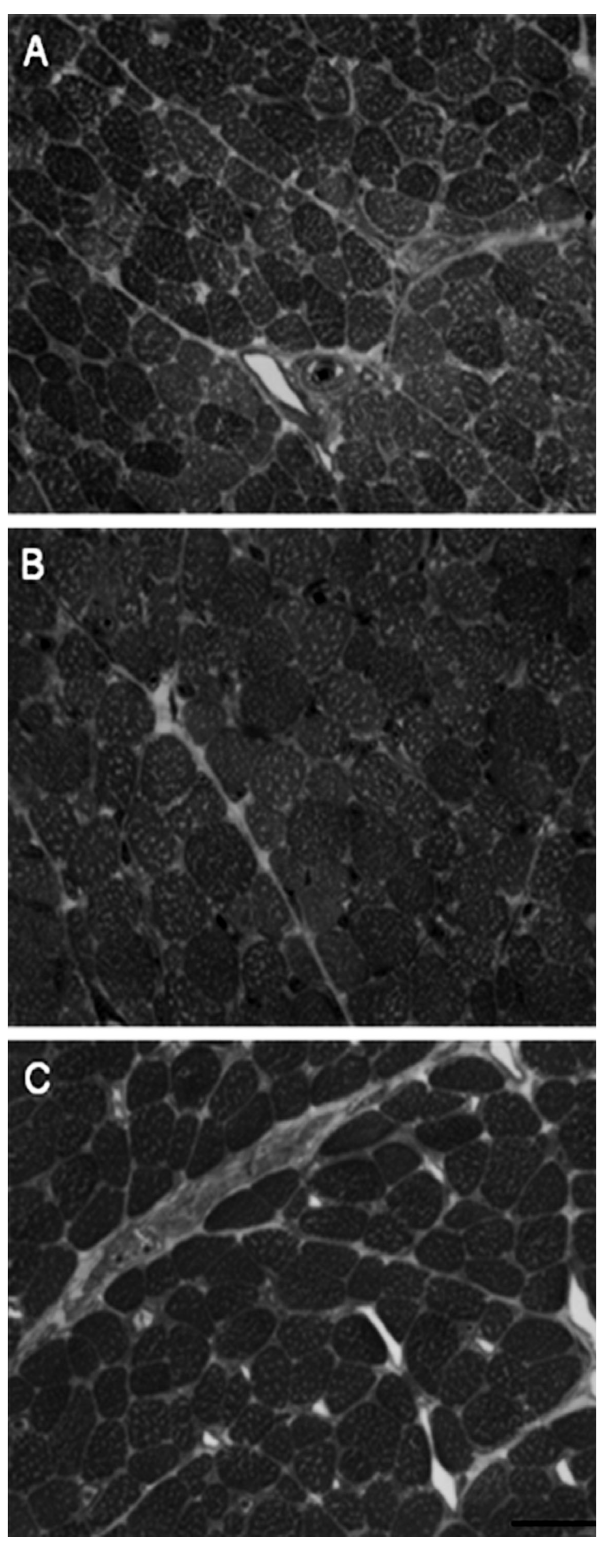
Figure 7. Morphological aspects of BC muscle after 120 minutes of incubation: ( A ) Krebs control, ( B ) 1 µg/mL and ( C ) 10 µg/mL Bmaj-9. Note the preserved polygonal cross-sectional profile of muscle fibers in all treatments. No damage was detected in muscle fibers. Bar = 50